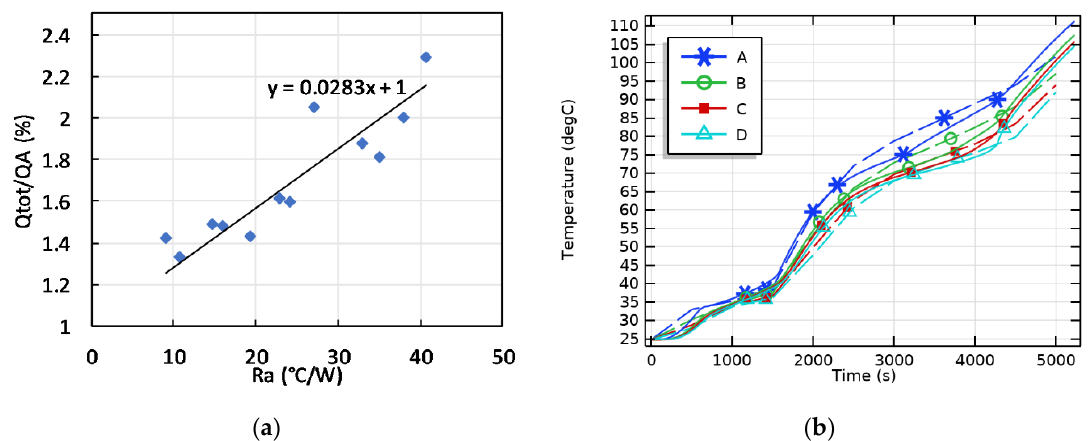
Figure 8. ( a ) Correlation between the thermal contact resistance (Ra) and the ratio between total heat entered at the bottom surface of the sample (Qtot) and that derived from probe heat flux (QA). ( b ) Comparison between experimental (solid lines) and modeled (dashed lines) temperatures at points A – D at different depth of the specimen, all laying in the active phase.